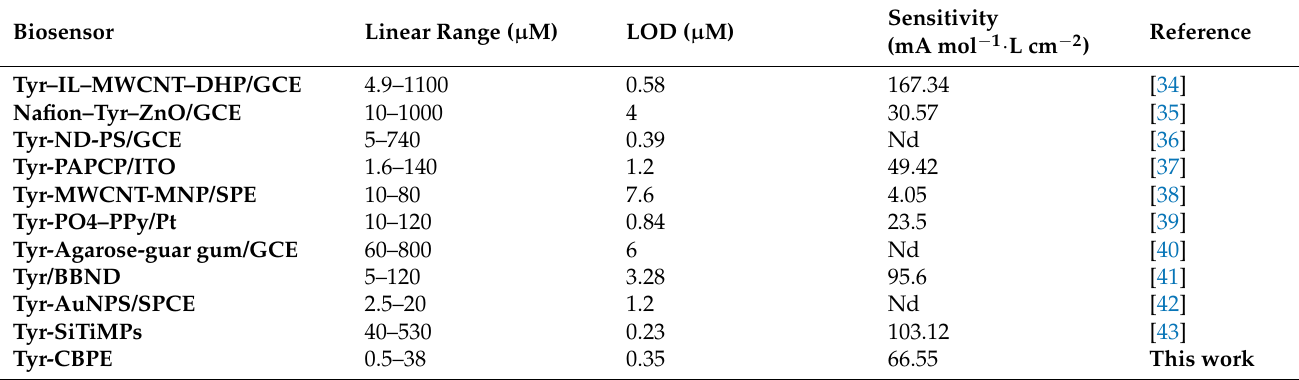
Table 1. Comparison of analytical performances of the Tyr-CBPE biosensor obtained for determination of catechol with others studies reported in the